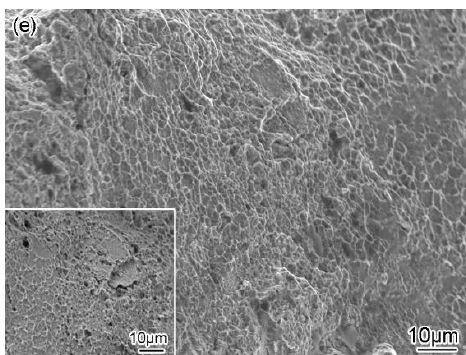
Figure 8. Fracture morphology of IFed alloy after the stress-rupture condition at 705 °C/897 MPa: ( a ) low magnification morphology, ( b ) the fracture source region, ( c ) small planes in the propagation region, ( d ) tearing edges and small planes in the propagation region, ( e ) the shear lip region.